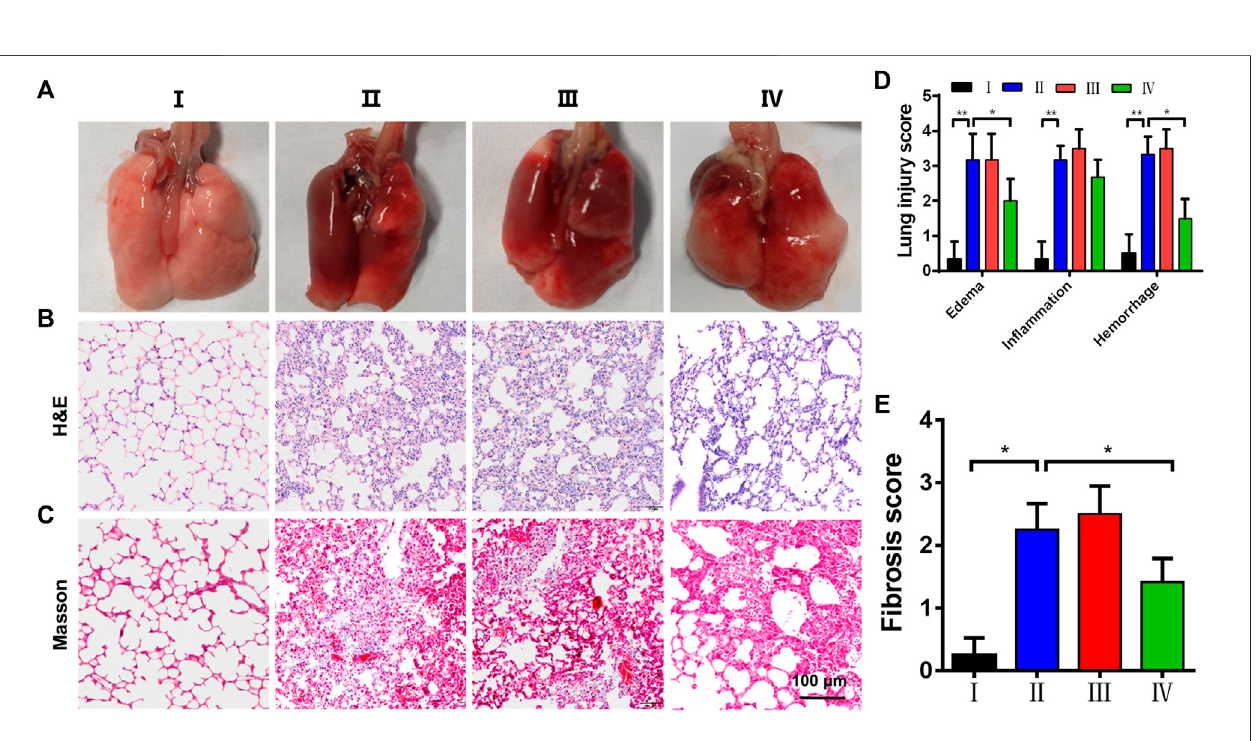
FIGURE 5 | The histopathological change of lung tissues. (A) Macroscopic appearance of lungs, (B,C) H&E and Masson ’ s trichrome staining of lungs; (D) pulmonary injury score (Smith score); and (E) pulmonary fi brosis score (Aschoff score) from mice treated with saline (control), LPS, LPS + Naked siZEB1/2 and LPS + ZPM@PDE-siZEB1/2. (* p < 0.05, ** p < 0.01, *** p < 0.001). For each group: Ⅰ , Control; Ⅱ , LPS; Ⅲ , LPS + Naked siZEB1/2; Ⅳ , LPS +